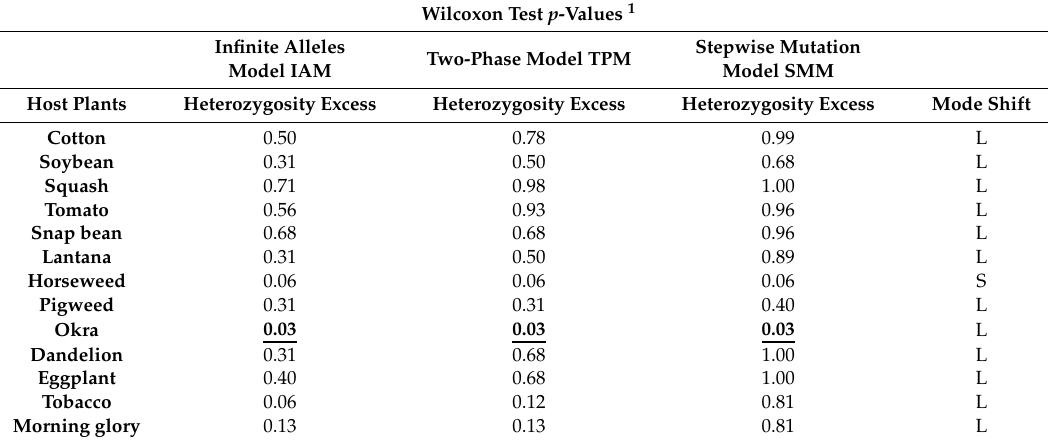
Table 5. Wilcoxon signed-rank test for mutation-drift equilibrium for 35 B. tabaci MEAM1 populations collected from di ff erent host plants, based on six microsatellite